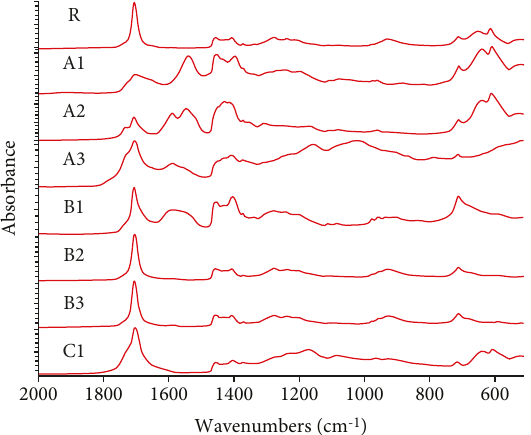
Figure 1: FT-IR spectra of the products obtained from a fatty acid/iron/carbon dioxide/water